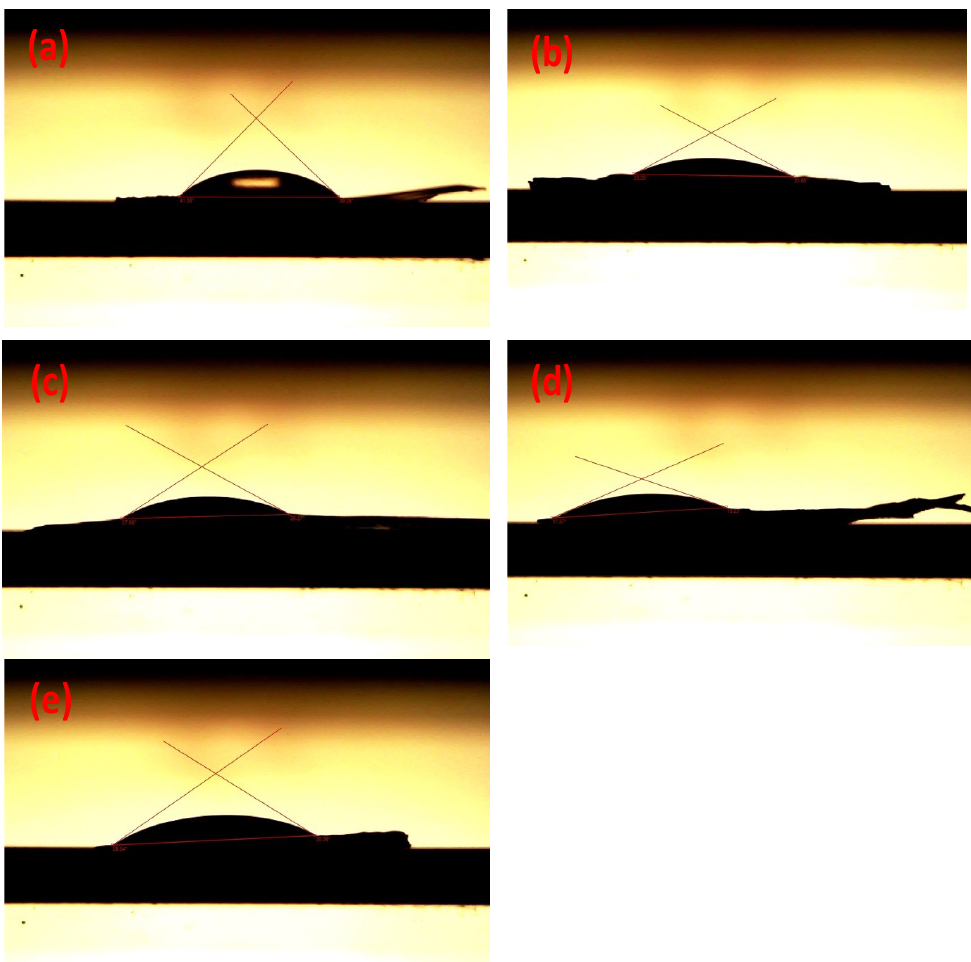
Figure 5. The contact angle of CA with different additives of metal oxides: ( a ) CA, ( b ) Sm 2 O 3 @CA, ( c ) MgO@CA, ( d ) Sm 2 O 3 /MgO@CA, ( e ) Sm 2 O 3 /MgO/GO@CA.